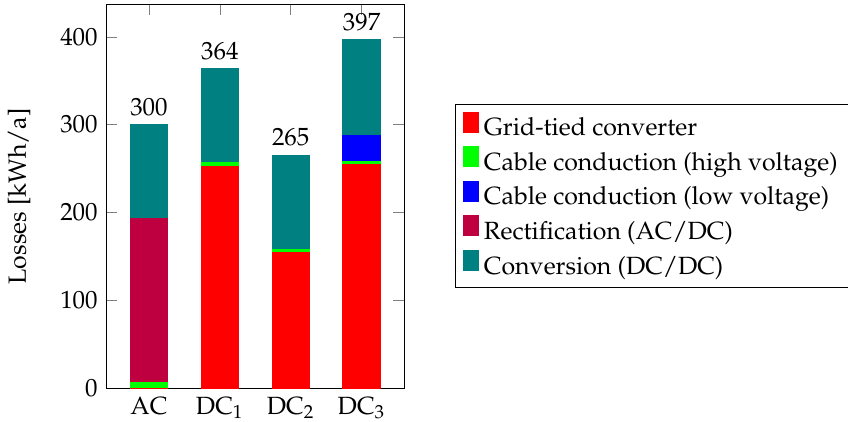
Figure 7. Annual system losses in the four modelled cases without PV and battery storage.